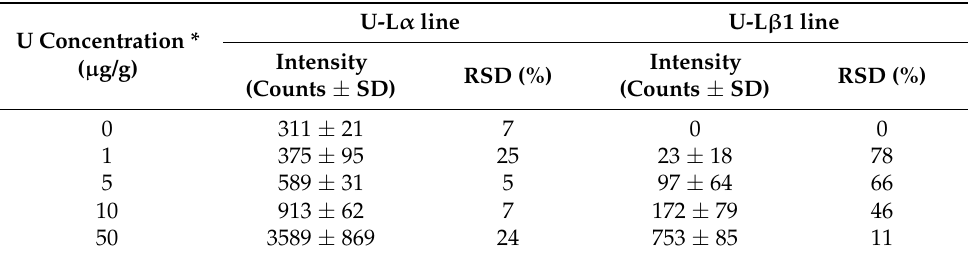
Table 2. X-ray intensity of U-L α and U-L β 1 lines in 1 µ L of mixed solutions of urine treated five- fold HNO 3 .